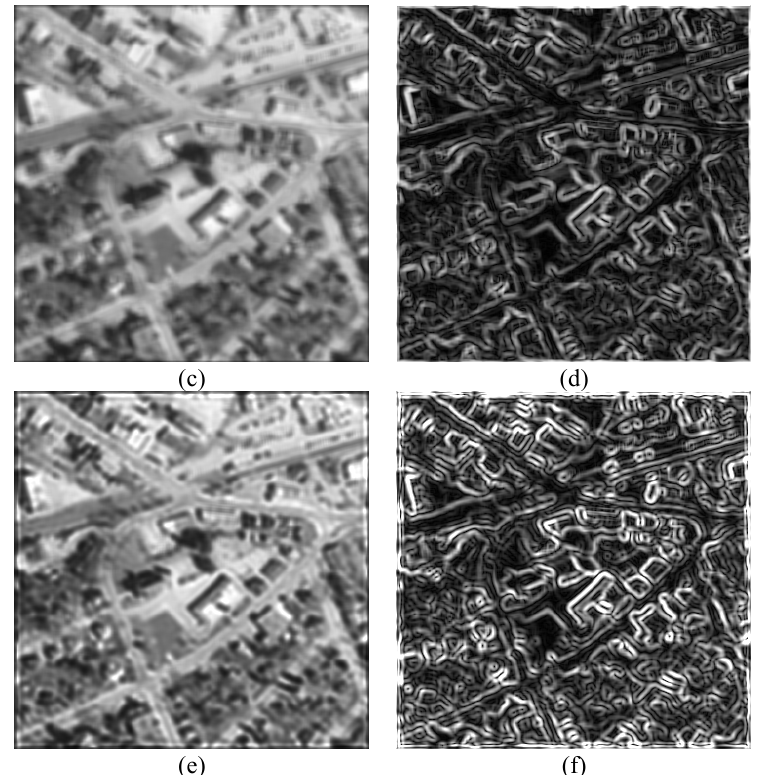
Fig. 8. Unique edges detection using the Sobel method. (a) Original image, (b) Edges of the original image, (c) Degraded image, (d) Edges of the degraded image, (e) Restored im- age , (f) Edges of the restored !"#$ ! !" ! !" ! !"